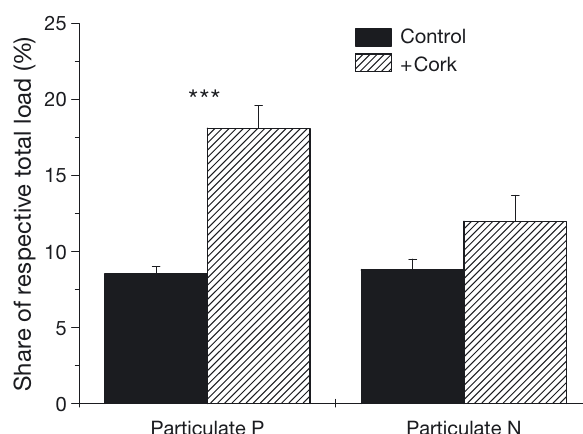
Fig. 14. Sampling depth (p < 0.0001) and diet (p < Fig. 13. Percentage of particulate phosphorus and nitrogen contributing to total loads under different dietary treat- ments. Values are mean ± SE